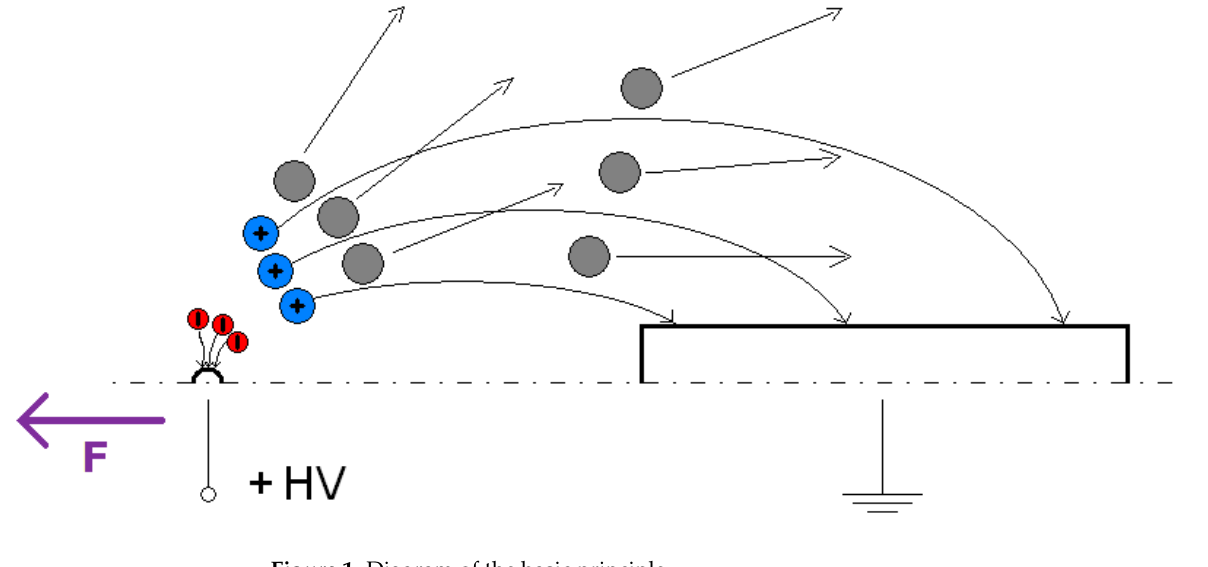
Figure 1. Diagram of the basic principle.